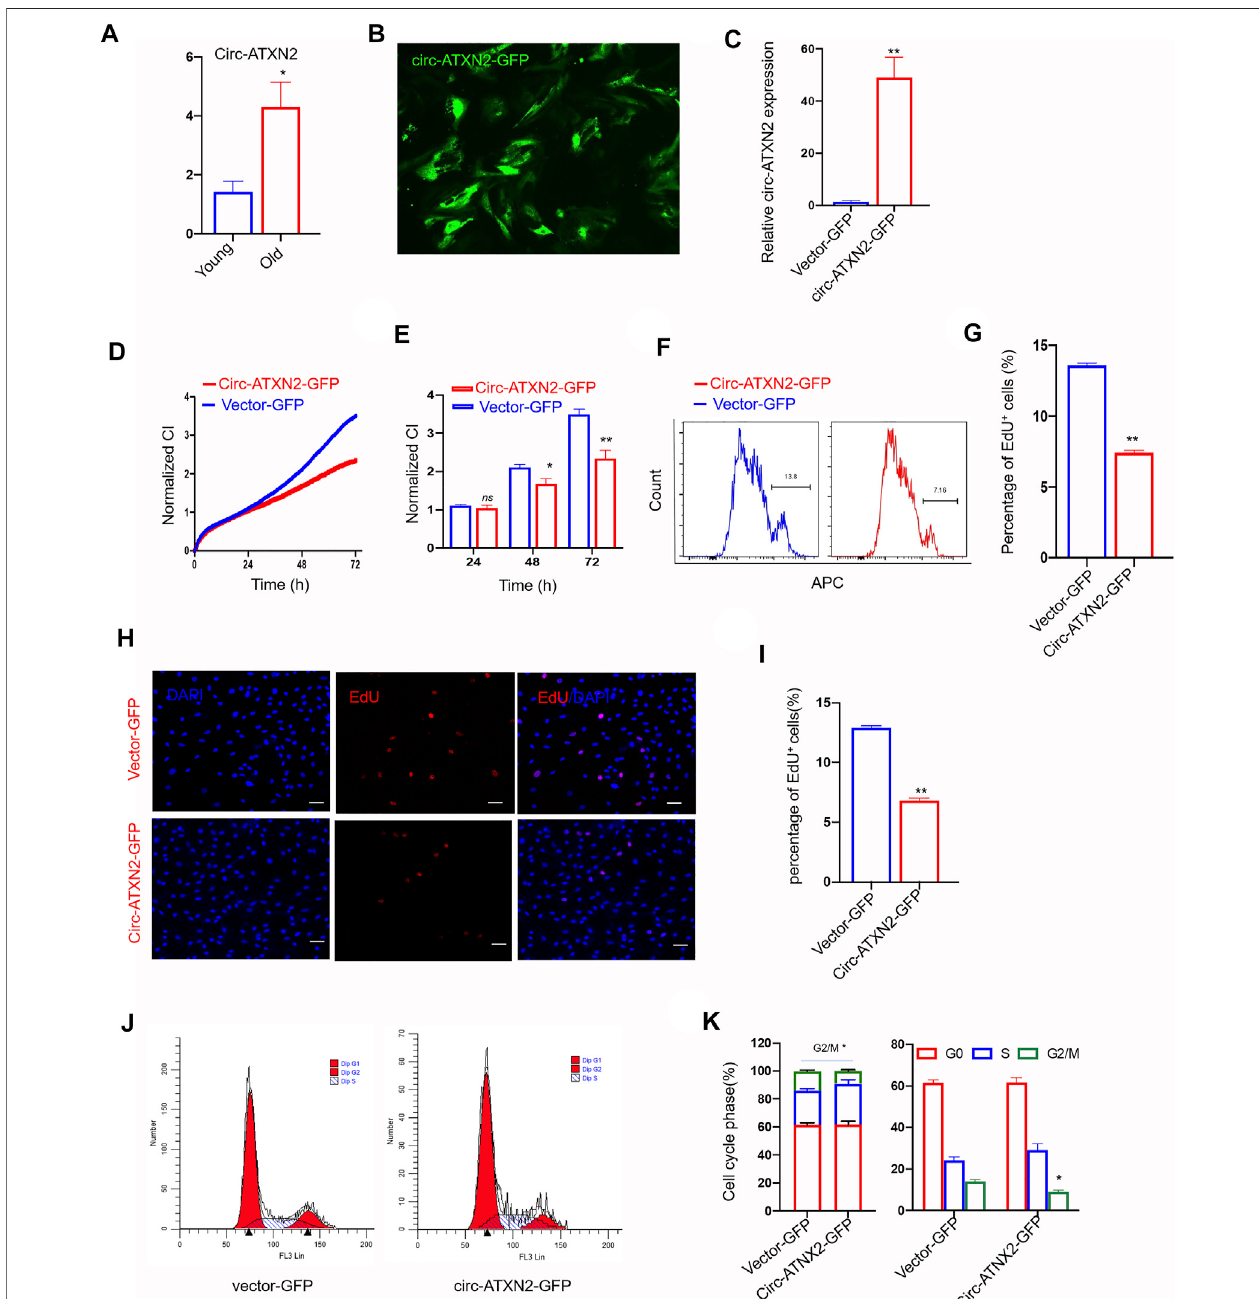
FIGURE 5 | Circ-ATXN2 overexpression inhibited proliferation in rat adipose-derived stromal cells (ASCs). (A) The relative gene expression of circ-ATXN2 after RNase R treatment (n (cid:1) 4, * p < 0.05 versus young group, statistical analysis was performed by Student ’ s t test). (B) Transfection ef fi ciency of circ-ATNX2 based on the expression of GFP in rat ASCs observed by fl uorescence microscope. (C) Validation of circ-ATNX2 over-expression-vector in rat ASCs by qPCR. Results were presented as mean ± SEM, by Student t test, n (cid:1) 6; ** p < 0.01. Cell proliferation was accessed by xCELLigence real-time cell analysis (RTCA) system assay (D – E) andEdUincorporationassay (F – I) .D.CellproliferationwasassessedusingRTCAfor72 h.Statisticsat24,48and72 h(E).CellIndex(CI)isanarbitraryunitre fl ectingthe electroniccell-sensorimpedance.Resultswerepresentedasmean ± SEM,bytwo-wayANOVA,n (cid:1) 3;* p < 0.05,** p < 0.01.F.Representativeimagesofcellproliferation were assayed using EdU incorporation by fl ow cytometry. (G) Statistics results were presented as mean ± SEM, by Student t test, n (cid:1) 3; ** p < 0.01. (H) Representative fl uorescence microscope images of cell proliferation was assayed using EdU incorporation. EdU positive cell was red. DAPI was blue. Scale bars: 20 µm. (I) Statistics data of EdU assay were presented as mean ± SEM, by Student t test, n (cid:1) 3; ** p < 0.01. Cell phases of the circ-ATXN2 overexpression cells were analyzed by fl ow cytometry (J) and statistics (K) . Results were presented as mean ± SEM, by Student ’ s t test, n (cid:1) 3; * p < 0.05. ns: not signi fi cant.